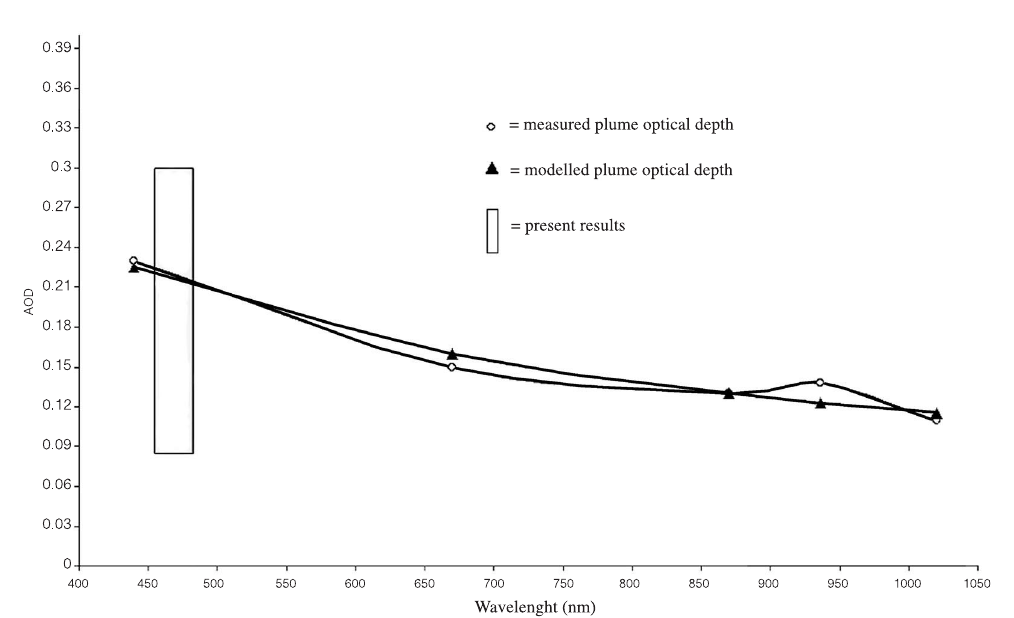
Fig. 6. Solid lines indicate the t a measured by sun-photometer (October 26th, 1997) and t a modelled using aerosol code (Oppenheimer, 1998). The rectangle indicates the t a range obtained from the inversion procedure of MIVIS data (June 16th,